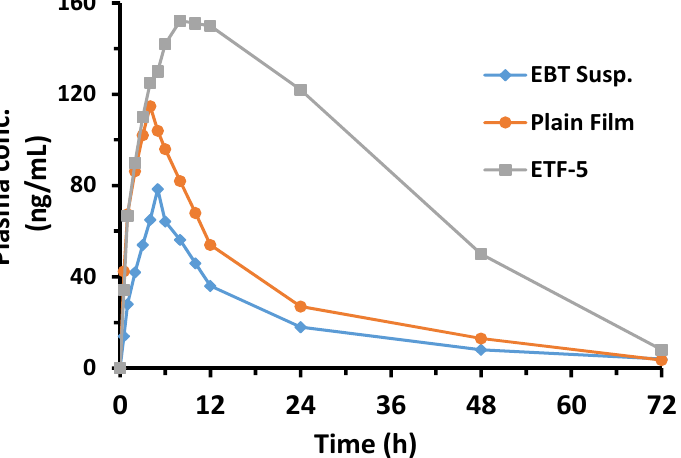
Figure 10. Mean plasma concentration-time profile for carebastine following oral treatment of EBT suspension, EBT plain film and ETF5. Table 4. Summary of in vivo pharmacokinetic parameters of carebastine following the administration of EBT suspension, EBT plain film and